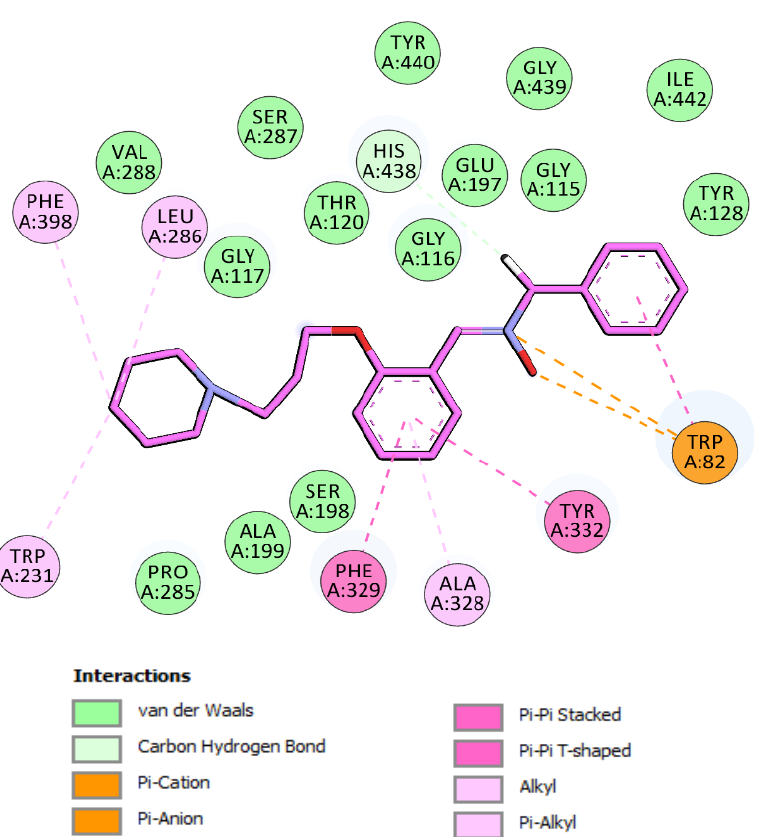
Figure 3. Schematic 2D representation of hBChE binding site amino acids interacting with nitrone 5 . Binding mode I.